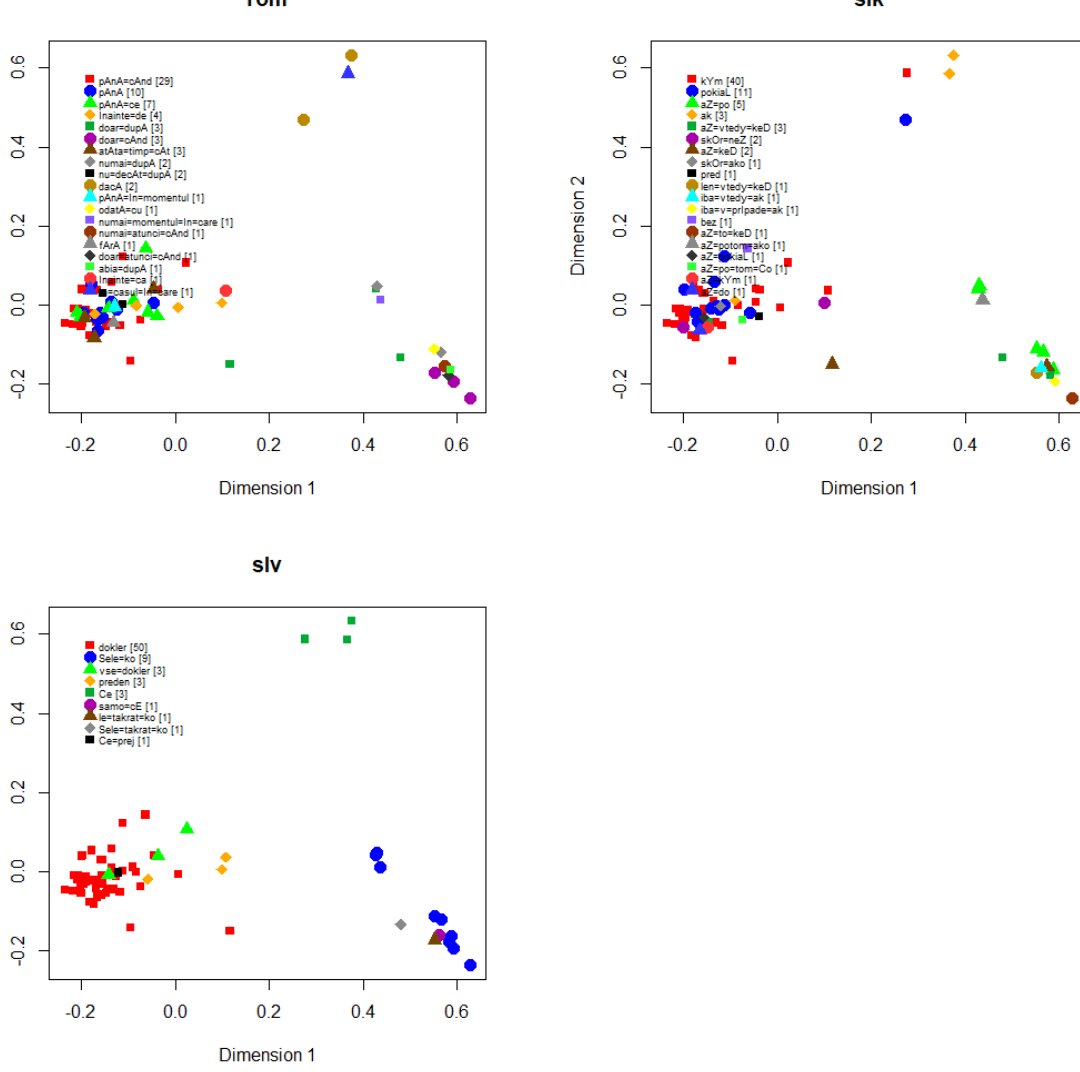
Figure A1. Maps of other languages than those in Figure